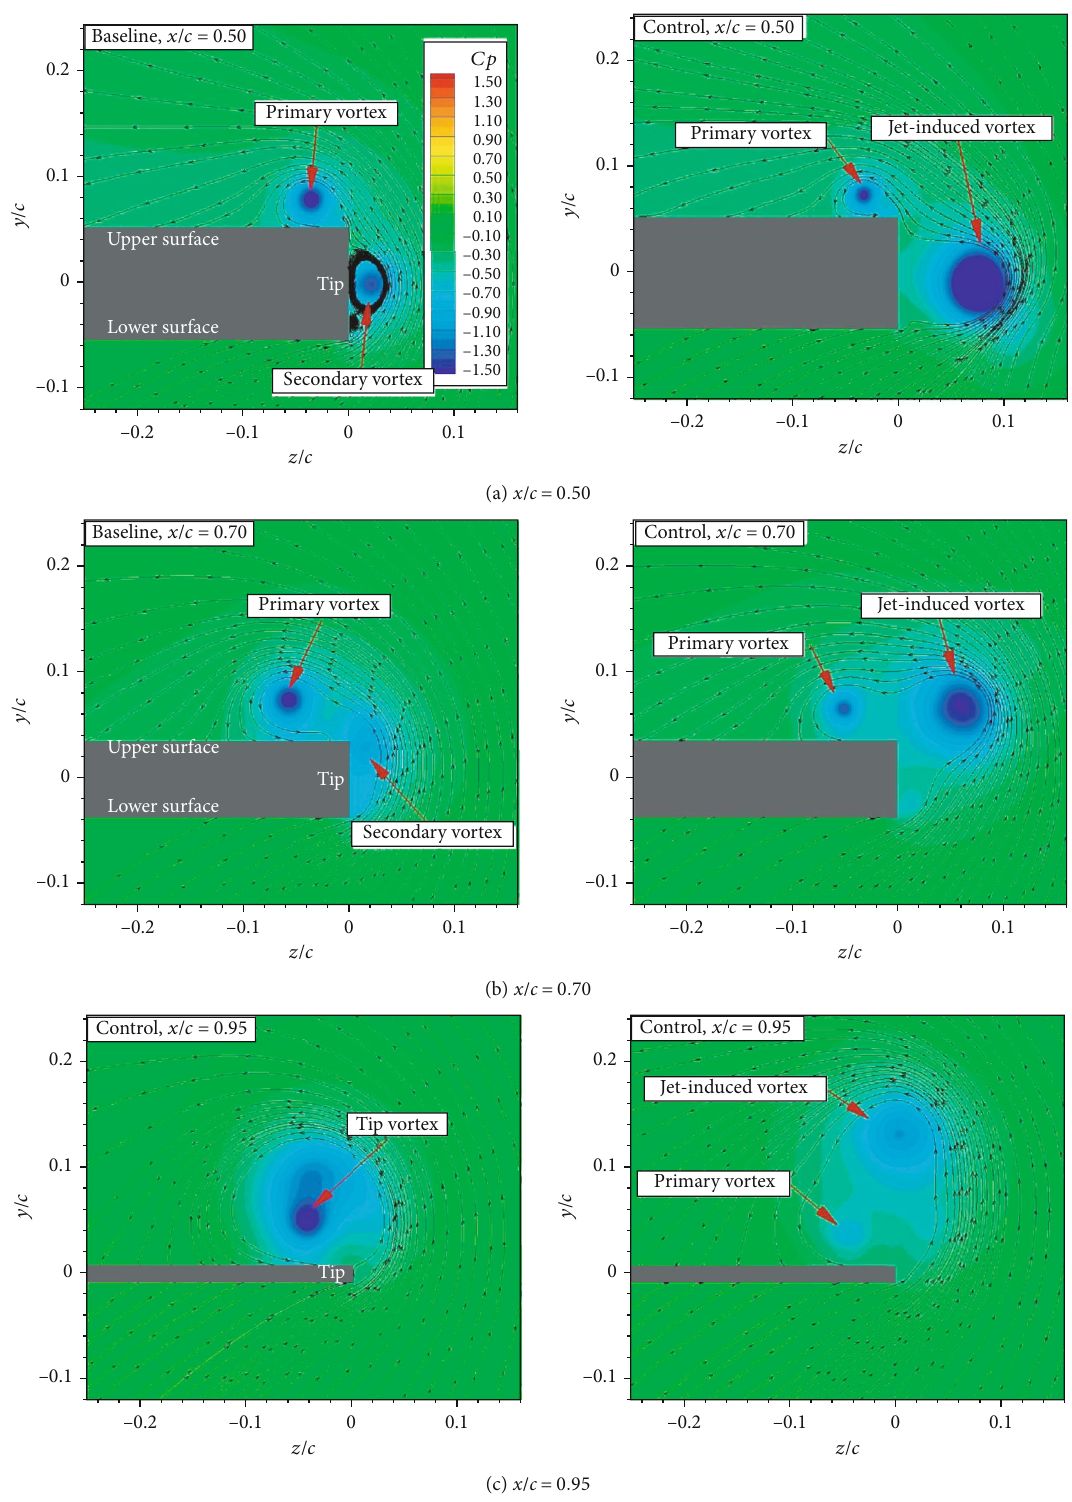
Figure 11: Time-averaged fl ow fi eld before and after normal